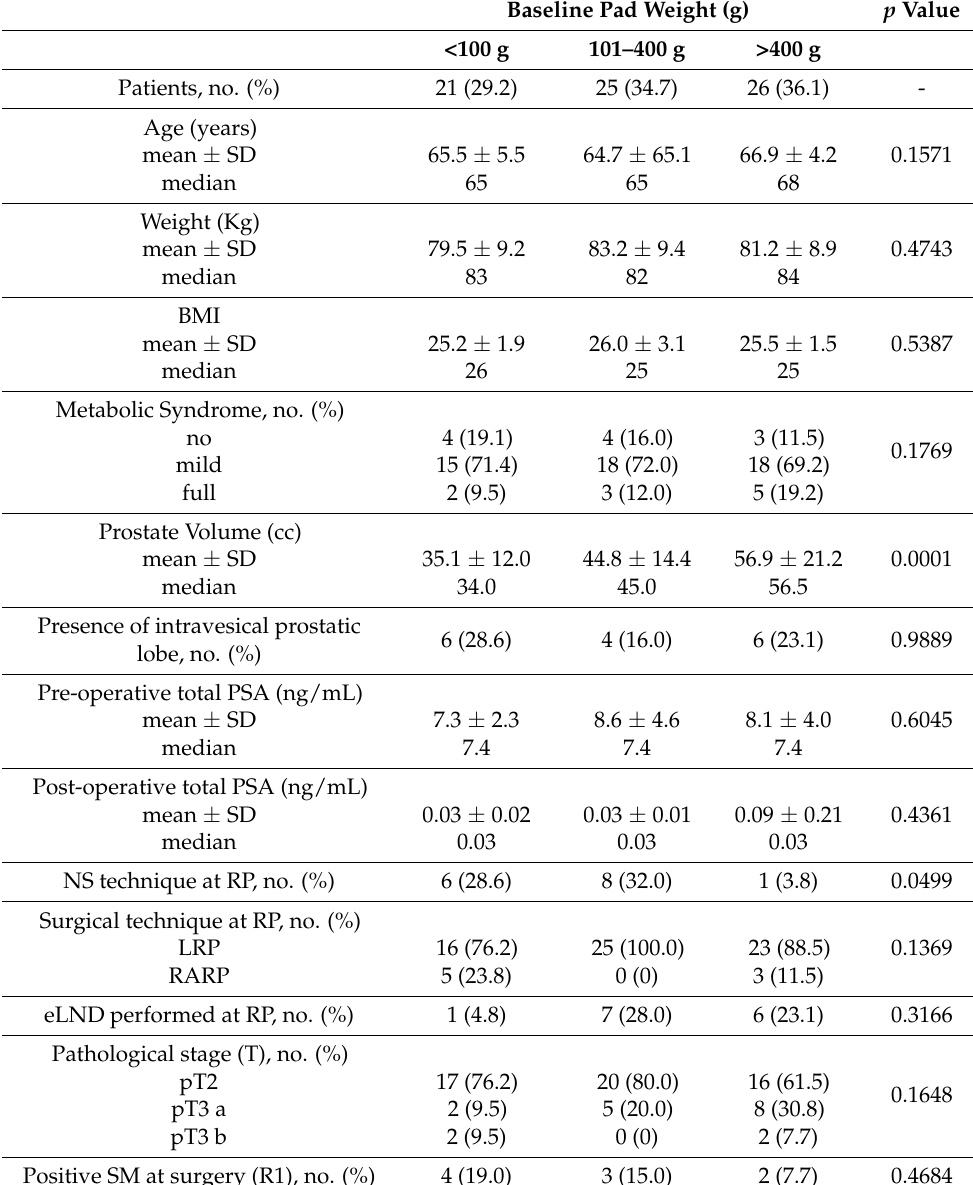
Table 3. Comparison of the characteristics of the population submitted to pelvic floor rehabilitation on the basis of baseline PAD weight ( ANOVA one-way test